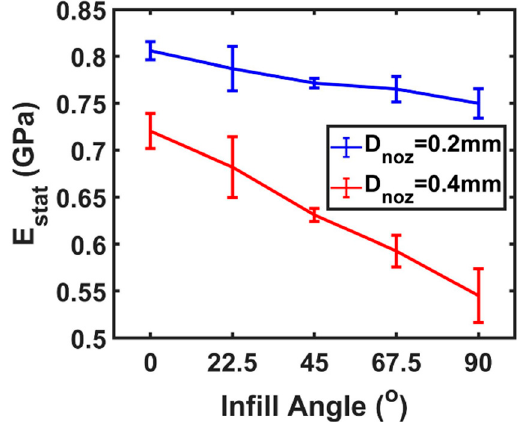
Figure 8. The static Young’s modulus versus the infill angle measured by the tensile test of printed ABS tensile specimens with 100% infill. Blue (red) line indicates the nozzle size of the extruder, D noz , i.e., the specimen is printed by a 0.2 mm (0.4 mm) nozzle. Each data point is the averaged value and the error bars represent the standard deviation.